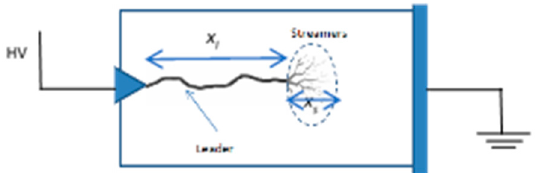
Figure 3. Illustration of leader column and streamers head of a discharge at the surface of an insulator.